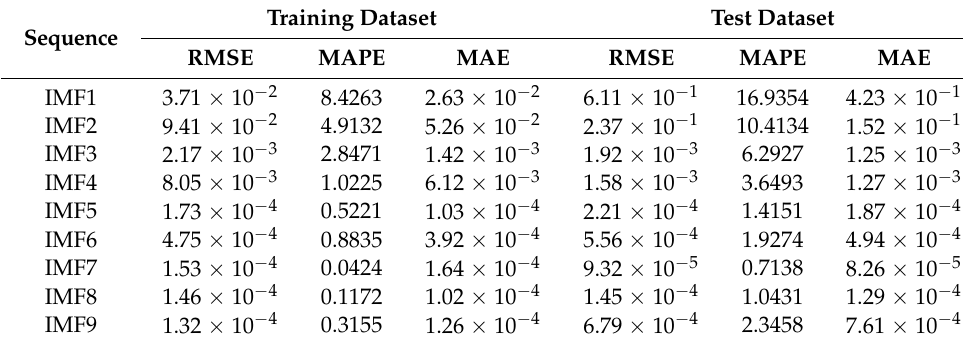
Table 2. Comparison of evaluation indicators of IMF sequences.